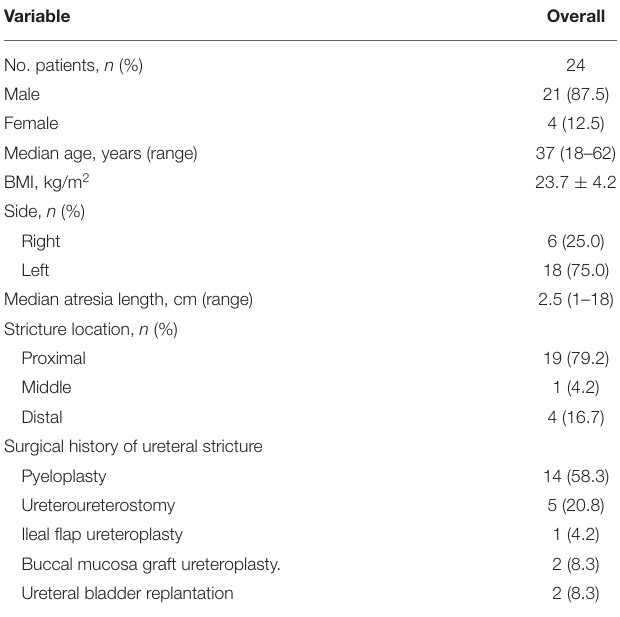
TABLE 1 | General characteristics of the patients.